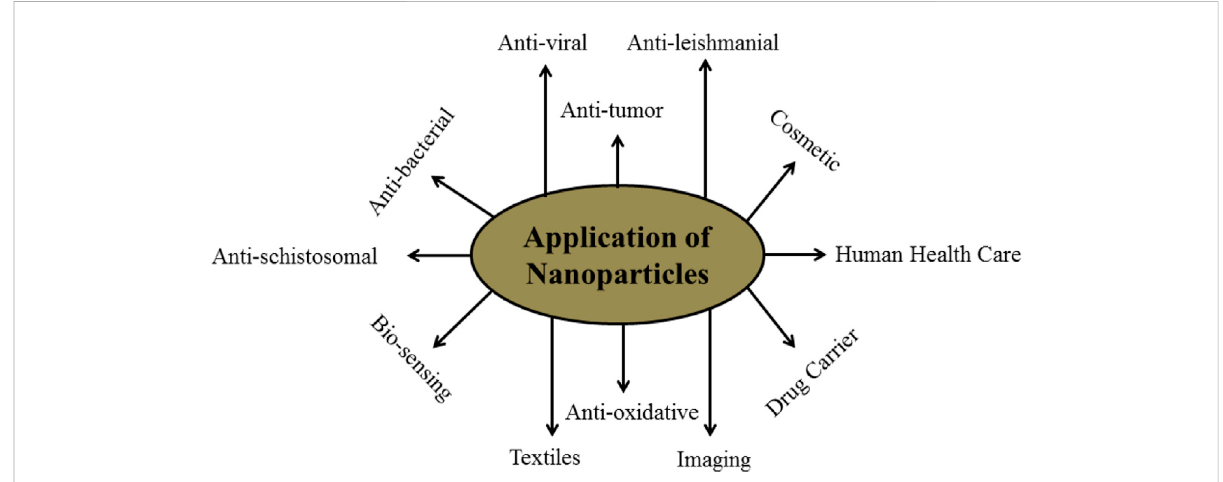
FIGURE 1 Schematic diagram of applications of Nanoparticles in various fi elds.